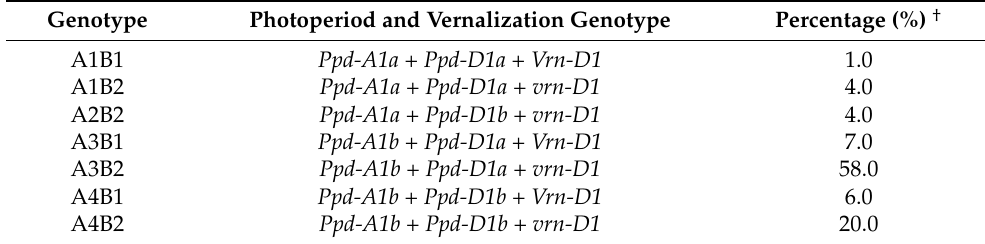
Table 1. Photoperiod and vernalization allelic combinations of 100 winter wheat varieties evaluated in three growing seasons (2016 – 2019).